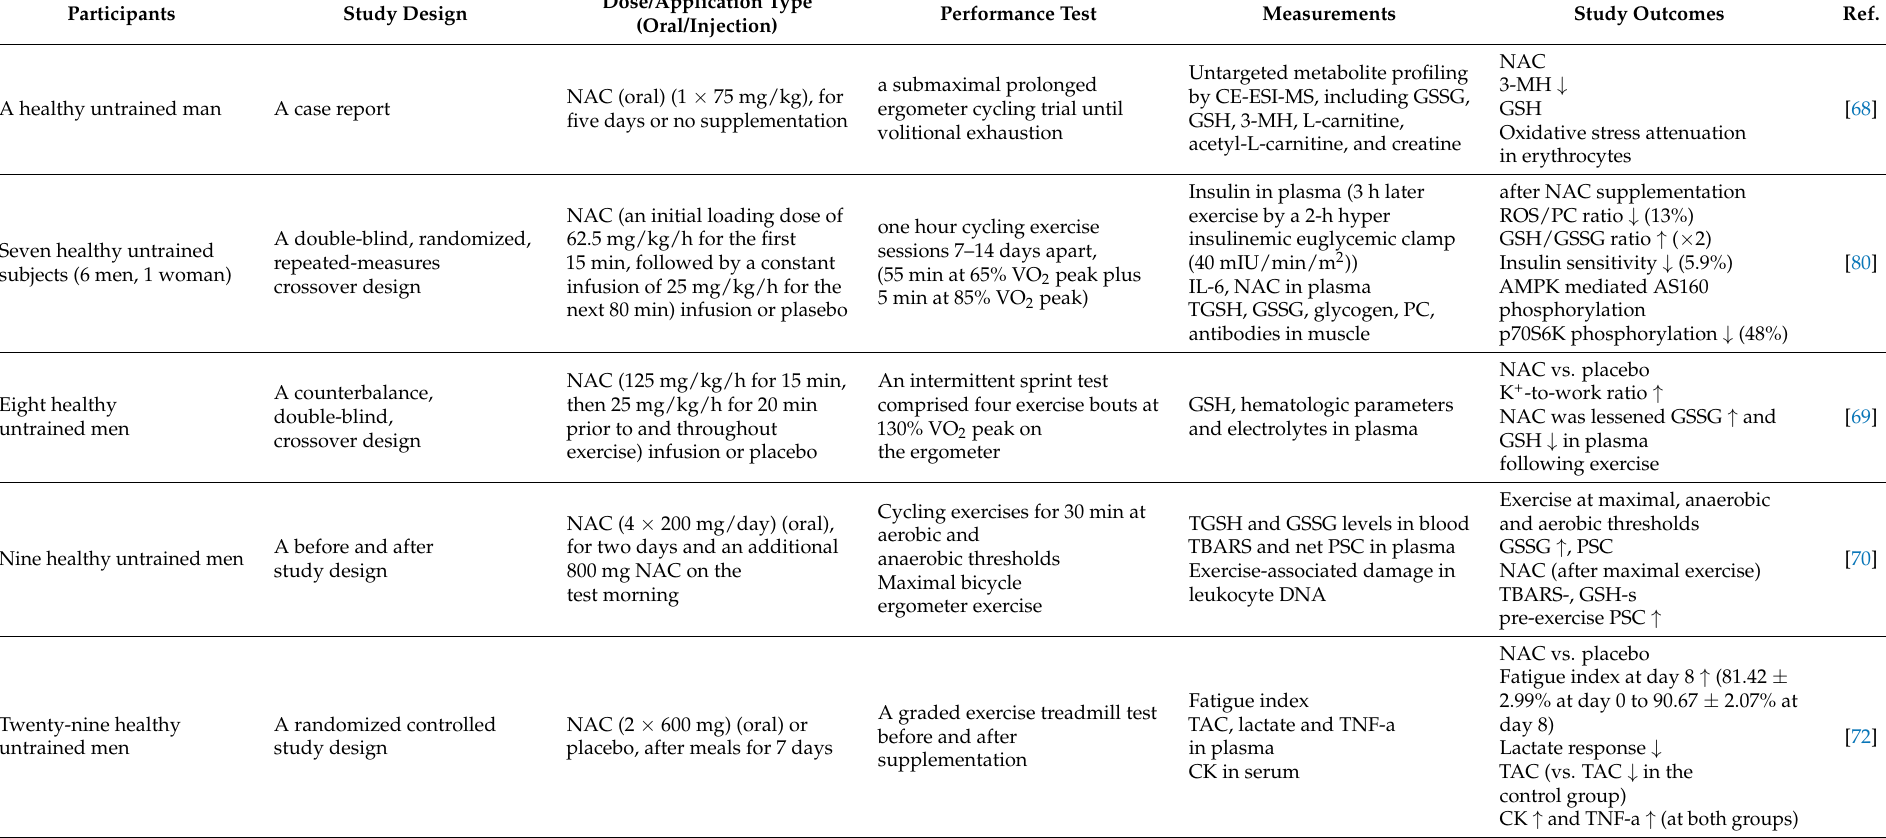
Table 1. Effects of N-acetylcysteine on mitohormesis and sarcohormesis in athletic